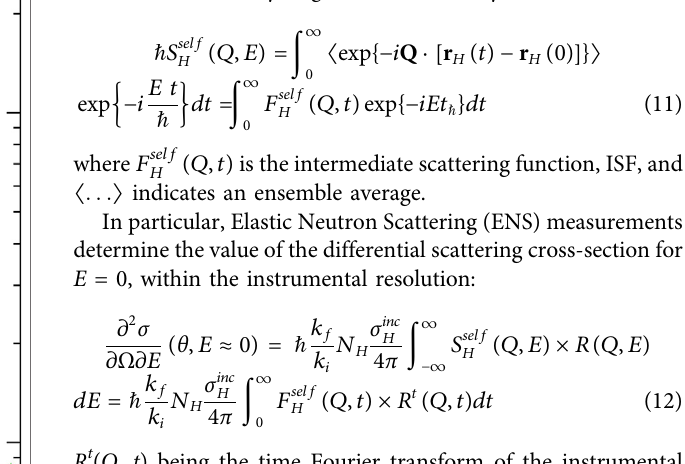
x (cid:2) Q ξ and Γ ( a ) and Γ ( a , b ) are the Gamma and incomplete Gamma function, respectively.